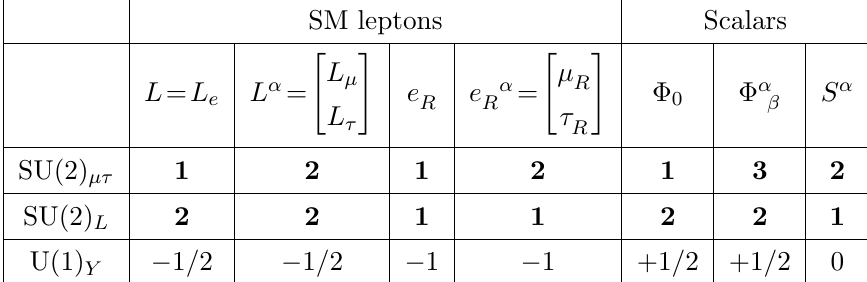
Table 1 . The particle content of the lepton and scalar sectors of the model and their quantum numbers under the SU(2) (cid:22)(cid:28) and SM SU(2) L and U(1) Y gauge groups. All these particles are colorless under SU(3) C , and all the other SM particles are singlets under the SU(2) (cid:22)(cid:28) . we reserve the (cid:12)rst few Greek letters for the (cid:13)avor indices of SU(2) the Lorentz indices. We note in passing that with the above-mentioned particle content, the model is free of gauge anomalies.